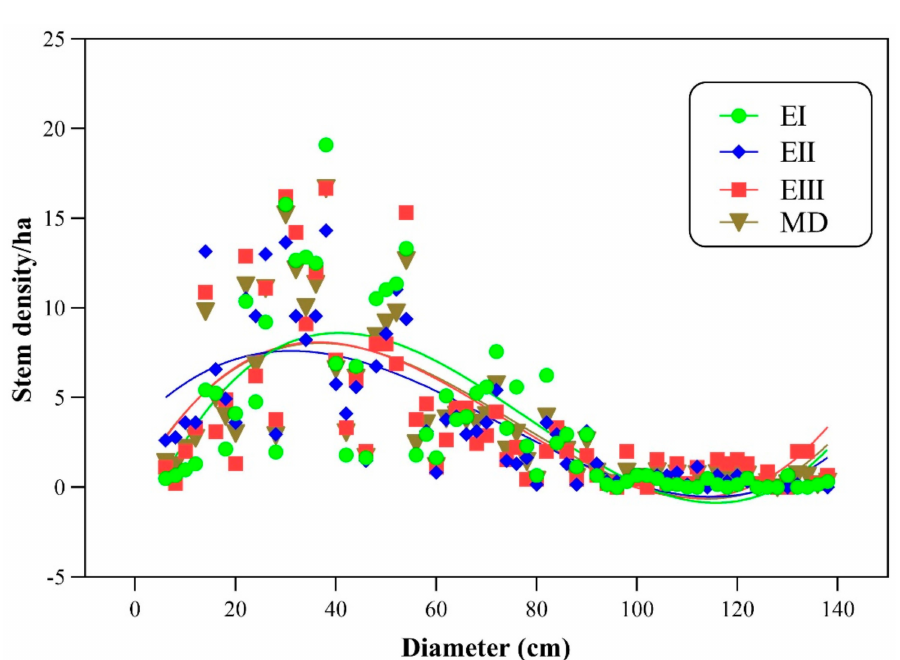
Figure 2. Relation between stem density (ha − 1 ) and diameter (cm). Note. DEI = density at elevation zone-I, DEII = density at elevation zone-II, DEIII = density at elevation zone-III, MD = mean